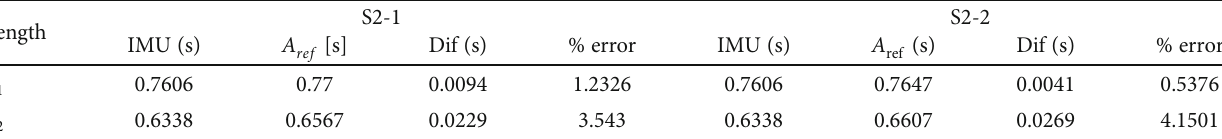
Figure 13: Frequency response for the oscillation tests in the two experimental units with the lengths L Table 7: Estimated errors of the IMU using